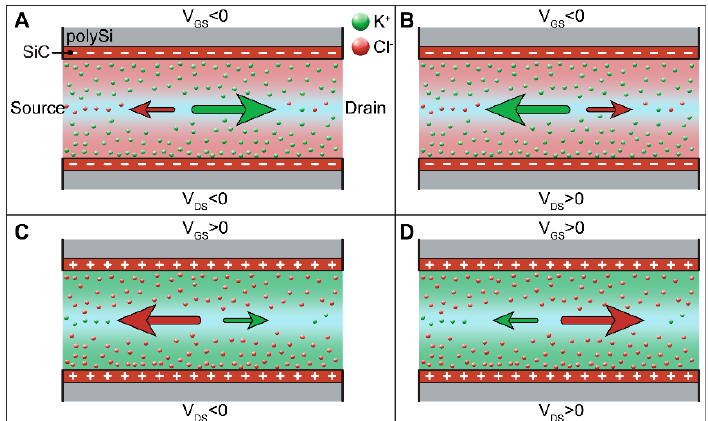
Figure 5. Ionic current I DS when gate potential V GS and transmembrane potential V DS are applied. Red points represent Cl − ions, while green points represent K + ions. ( A ) V DS < 0 V and V GS < 0; ( B ) V DS > 0 V and V GS < 0; ( C ) V DS < 0 V and V GS > 0; ( D ) V DS > 0 V and V GS > 0.V DS < 0 V attracts positive potassium ions K + to the drain electrode, whereas V DS > 0 V attracts negative chloride ions Cl − to the source electrode. V GS > 0 V draws Cl − to the nanochannel wall, creating a negatively charged EDL. Consequently, the number of negative ions in the nanochannel increases, and positive ions K + are repelled. V GS < 0 V attracts K + to the nanochannel walls, leading to an increased number of K + and a decreased number of Cl − .